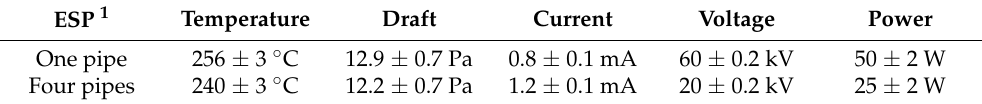
Table 1. Average value of basic measured parameters of the precipitation